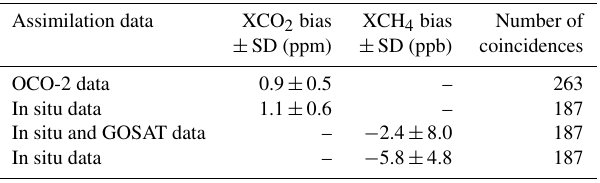
Table 3. This table presents the results of the comparison between the COCCON station in Namibia and the GOSAT M-gain and H- gain specific target observations. Bias and SD are given as the mean difference and 1 standard deviation between the coincident GOSAT and COCCON observations.